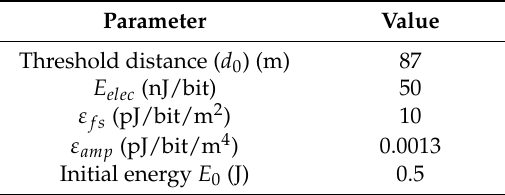
Table 1. Parameters of the